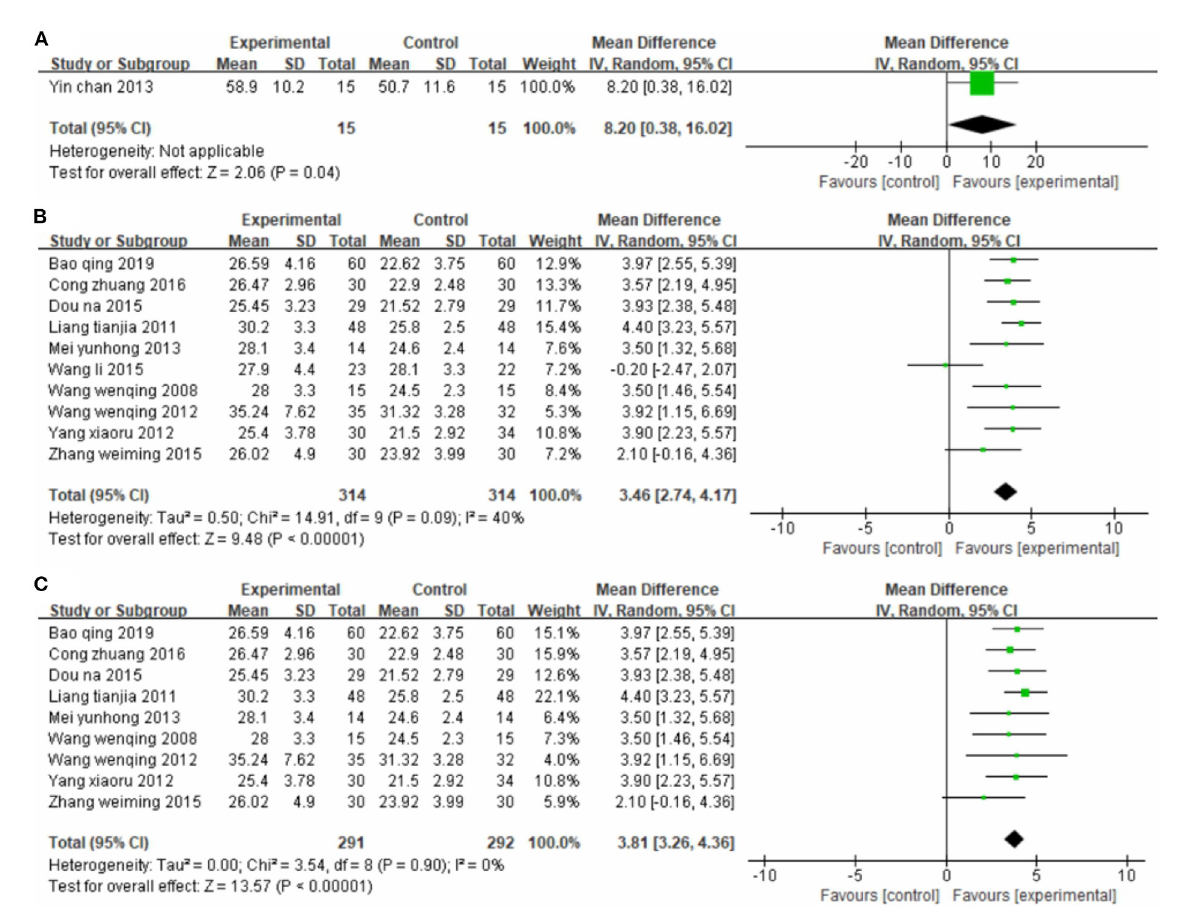
(Figure 5A). Our pooled data analysis showed that patients in the experimental group spent less time on the TUGT, with